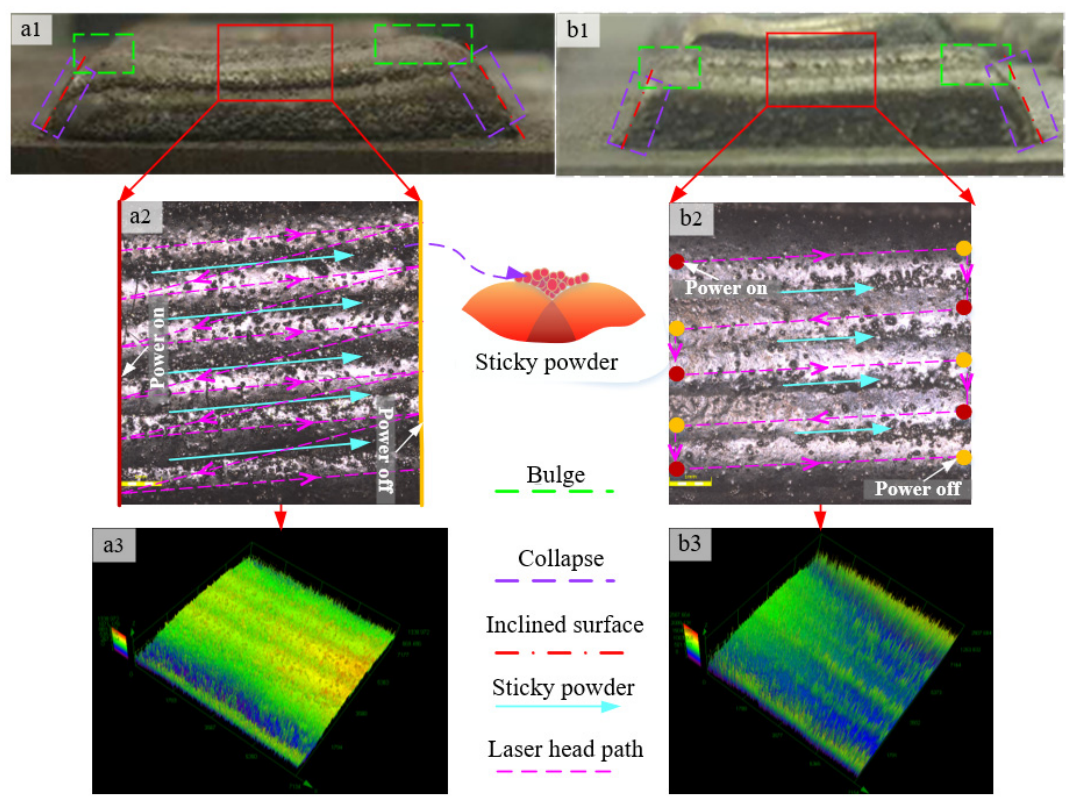
Figure 11. Morphologies of deposition layers under different scanning strategies: ( a1 ) Strategy II-1, ( a2 ) enlarged view of a1, ( a3 ) 3D morphology of a2, ( b1 ) Strategy II-2, ( b2 ) enlarged view of b1, ( b3 ) 3D morphology of b2.